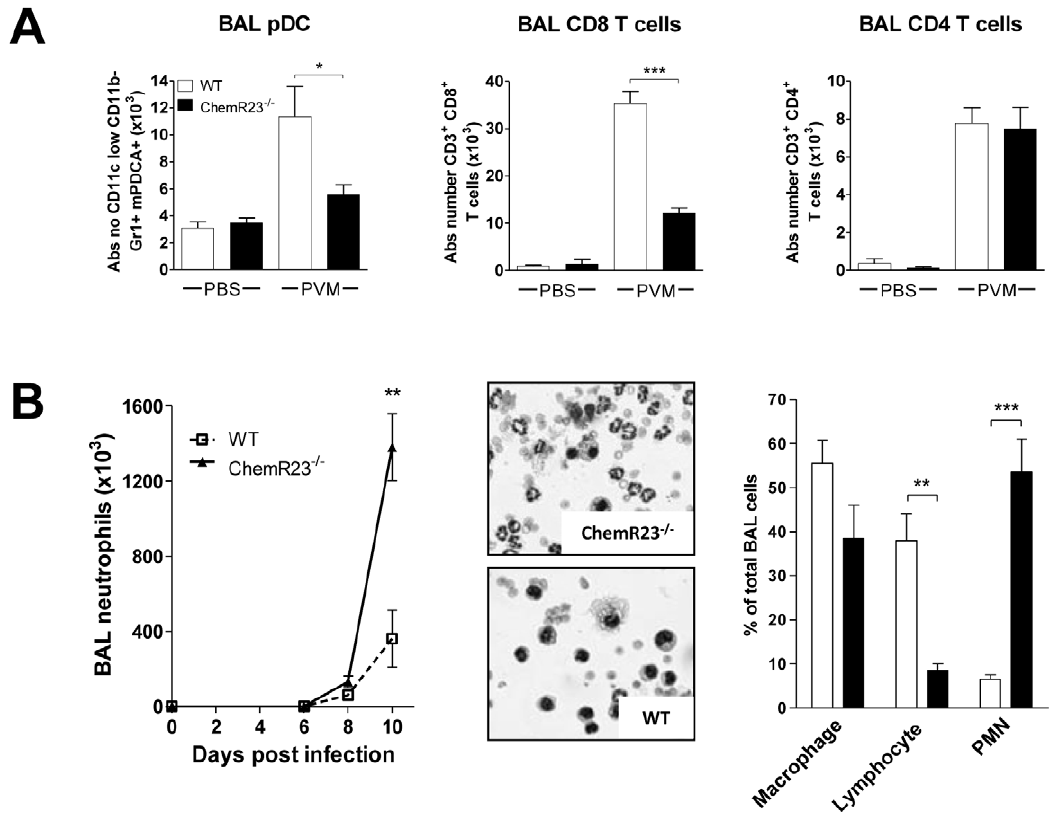
Figure 6. Decreased recruitment of pDCs and CD8 + T lymphocytes and higher recruitment of neutrophils to the lung of infected ChemR23-deficient mice. ( A ) Absolute numbers of pDCs, CD8 + and CD4 + T lymphocytes determined by flow cytometry in BAL fluids obtained from wild-type (WT) (white bars) and ChemR23 2 / 2 mice (black bars), either non-infected or at day 8 post-infection. ( B ) Neutrophil counts were determined in BAL fluids at different time points post-infection in WT and ChemR23 2 / 2 mice (left panel). Hematoxylin-eosin staining as well as the relative cell counts performed on cytospin preparations (middle and right panels) from BAL fluids obtained from wild-type (white bars) and ChemR23 2 / 2 mice (black bars) at day 10 post-infection are displayed. Data are the mean 6 SEM for groups of at least five animals. *, p , 0.05; **, p , 0.01; ***, p , 0.001.